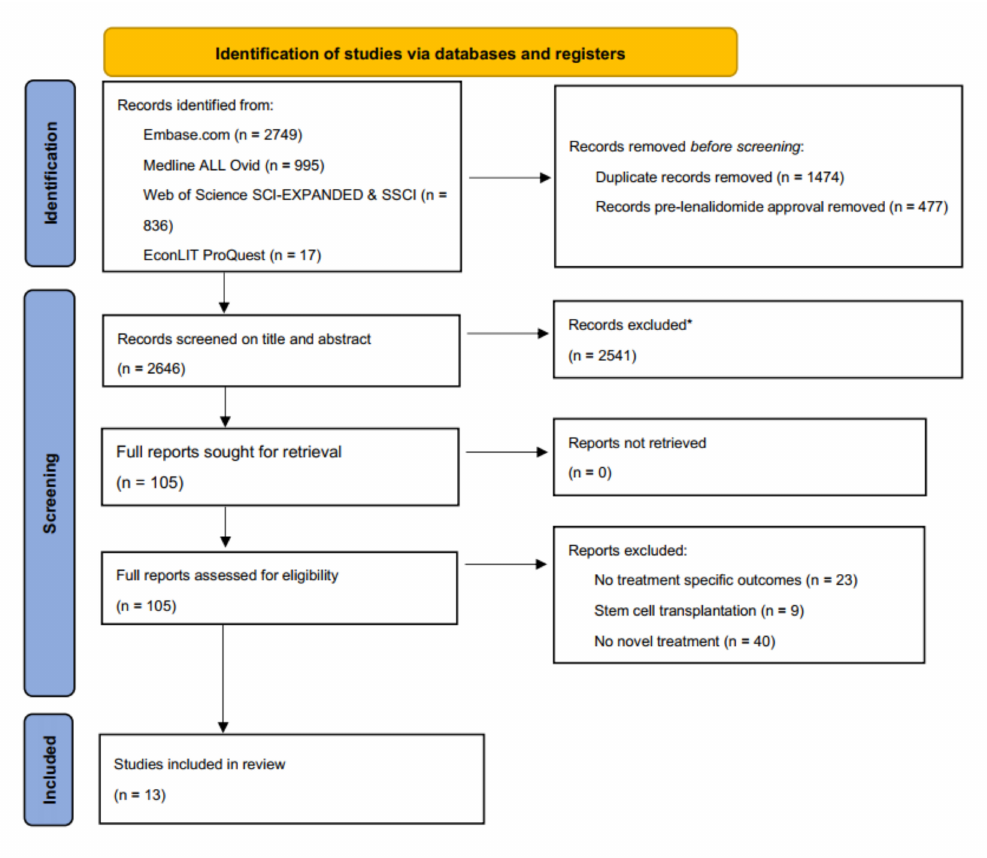
Figure 1. PRISMA flowchart. * Excluded on basis of exclusion criteria, e.g., no multiple myeloma, no active anti-MM treatment, no costs described,